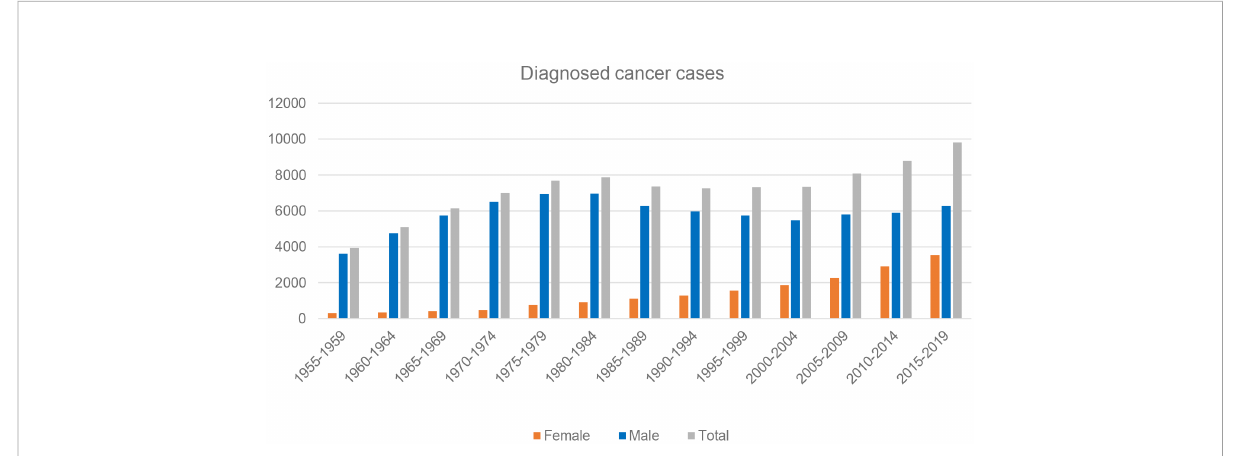
FIGURE 1 Diagnosed lung cancer cases by gender in selected radon-exposed municipalities in Finland from 1955 to